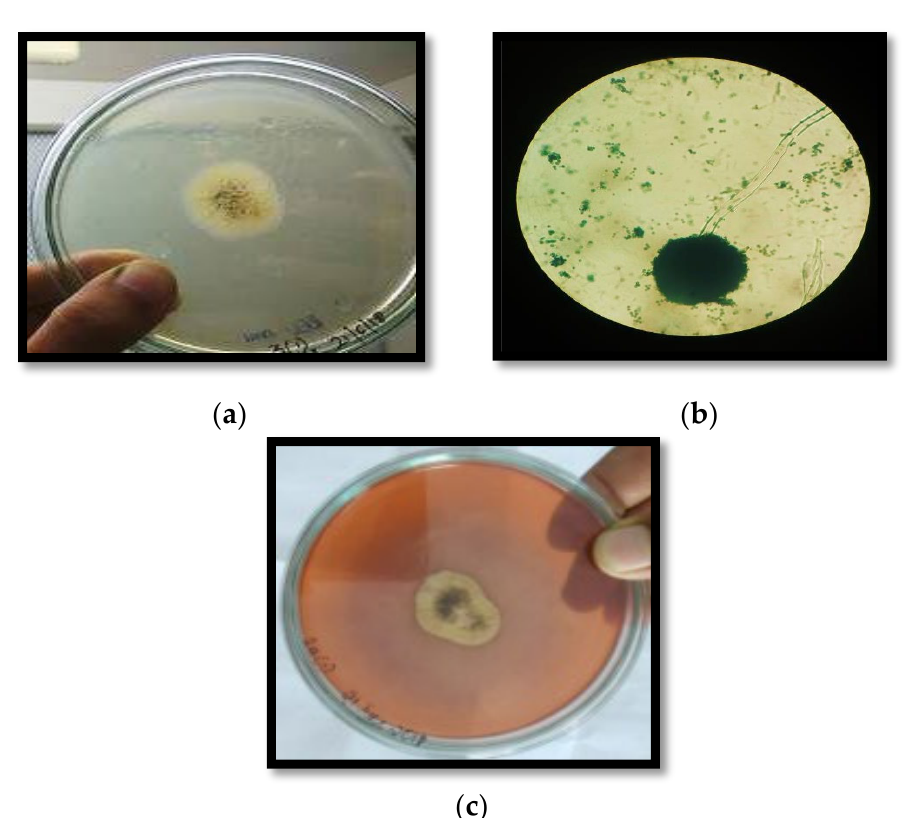
Figure 2. Characterization of the isolate ARS2 ( a ) point inoculated, ( b ) lacto phenol cotton blue stain- ing (40×) scale bar (100 µm), and ( c ) qualitativescreening based on the zone of clearance.